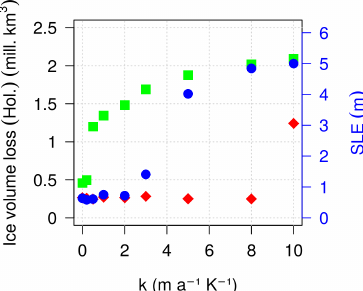
Figure 9. Distribution of the ice volume lost in the Holocene as a function of the heat-flux coefficient κ , simulated for three selected reference basal melting rates ( B ref = 1ma − 1 in green, B ref = 10ma − 1 in blue and B ref = 30ma − 1 in red). The ice vol- ume loss is calculated between the time at which the ice volume reaches its maximum value before the deglaciation and the present day. The green points are the same as the circles of Fig. 8a (for the